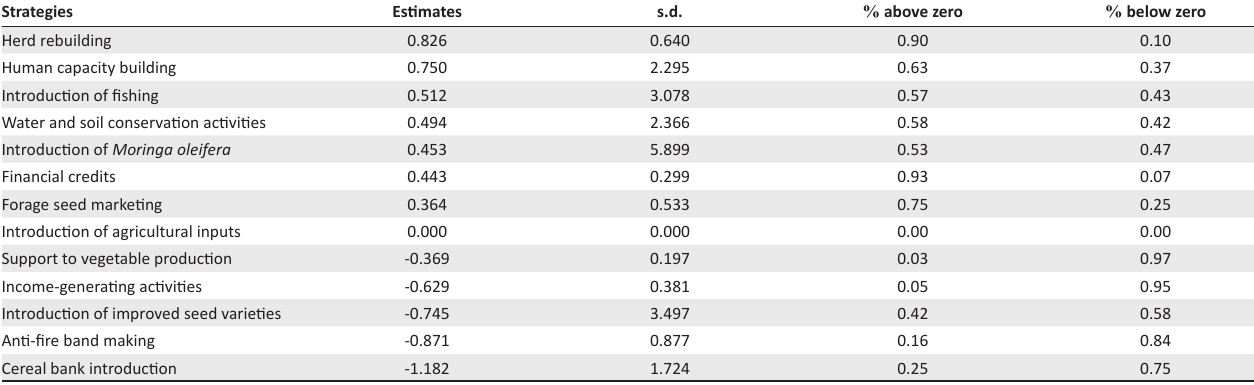
TABLE 3: The probability above and below the mean for each strategy. Strategies